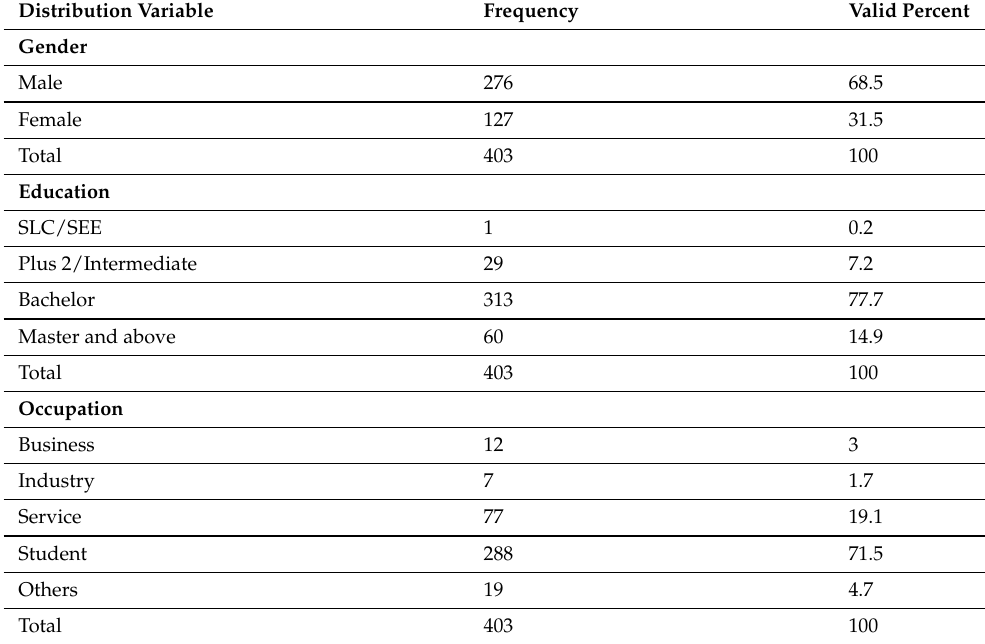
Table 1. Frequency distribution of demographic variables.